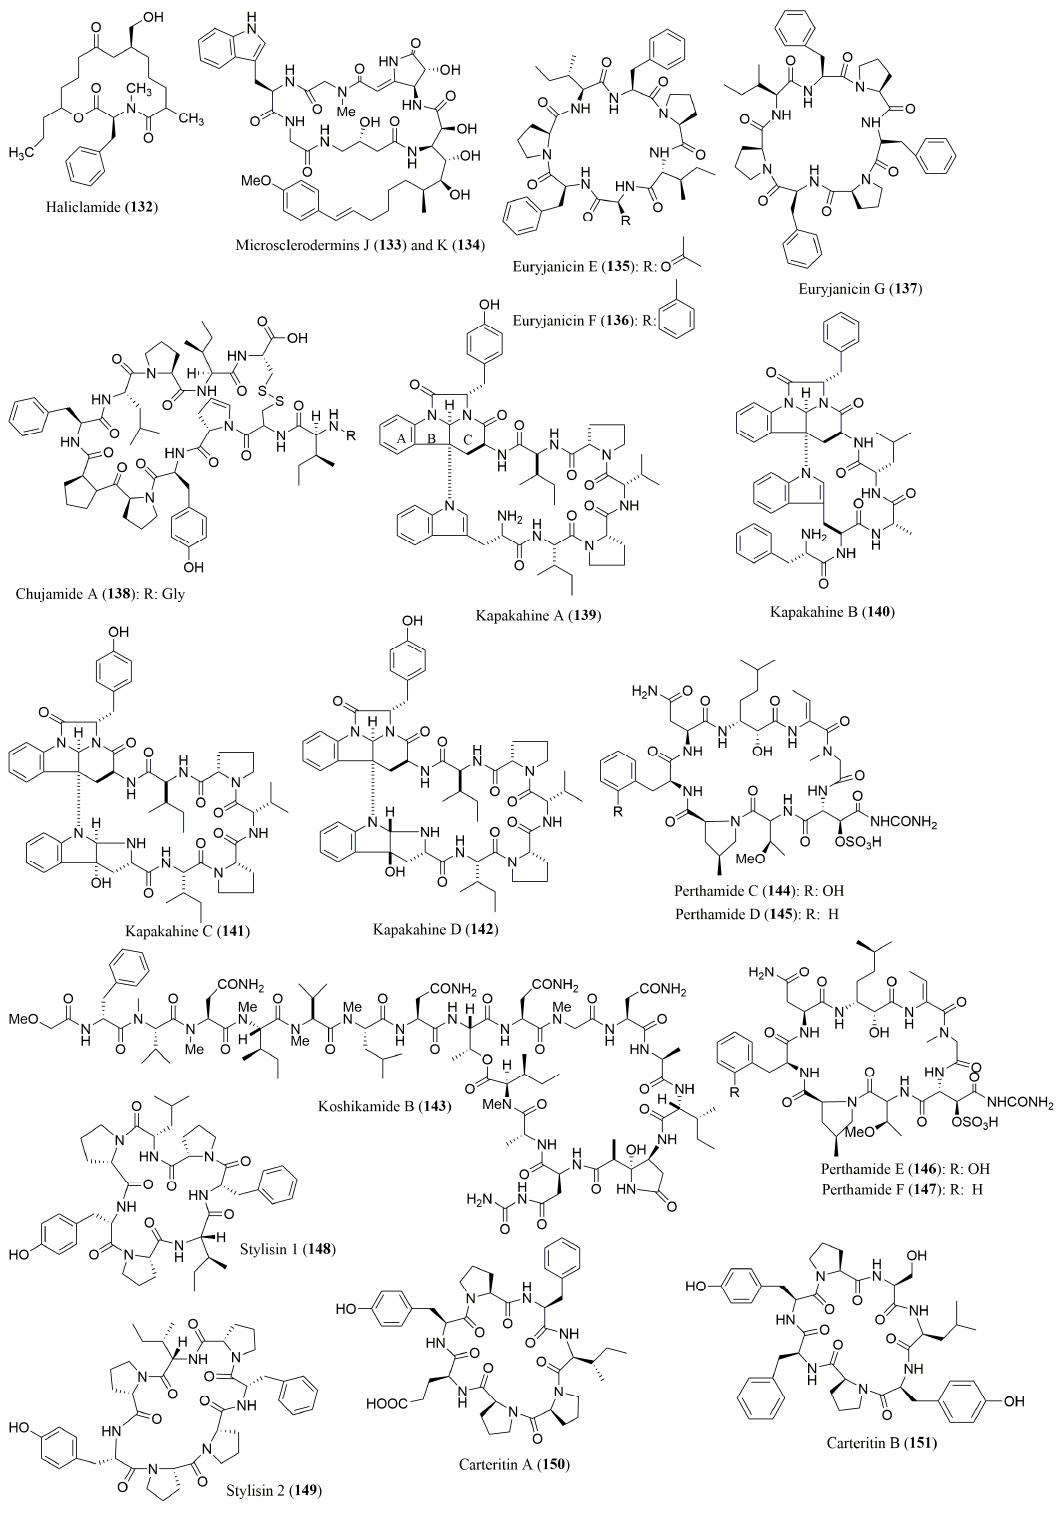
Figure 10. Structure of cyclic peptides 132 – 151 , isolated from marine sponges.